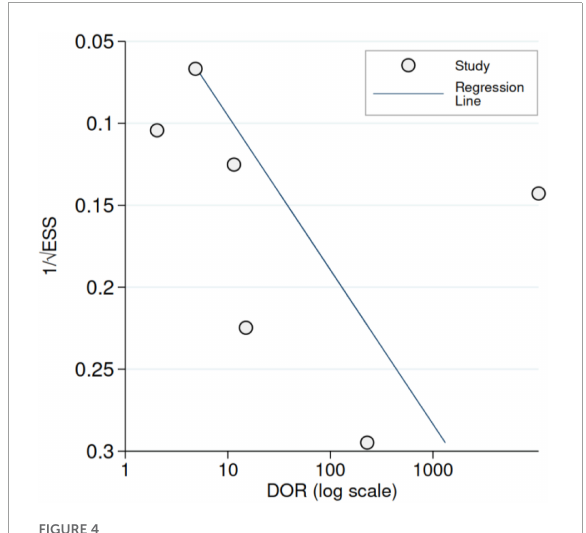
FIGURE4 Funnel plot with Deek’s regression line [predicted diagnostic